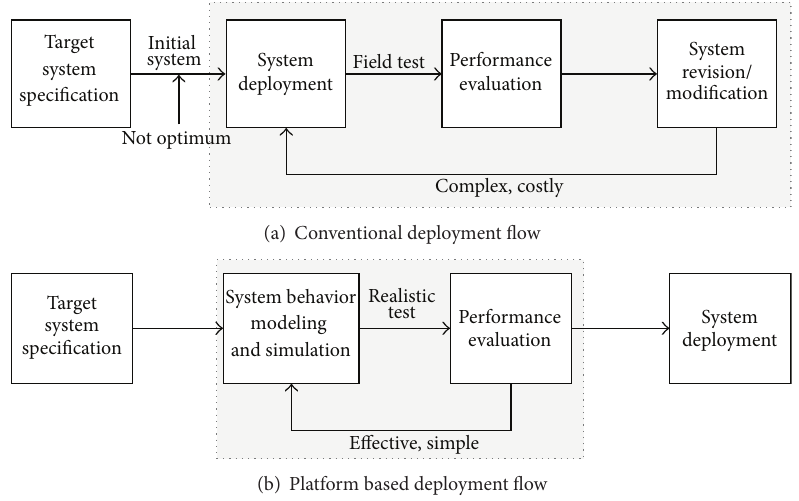
Figure 1: Comparison of two different surveillance system design and deployment methods.